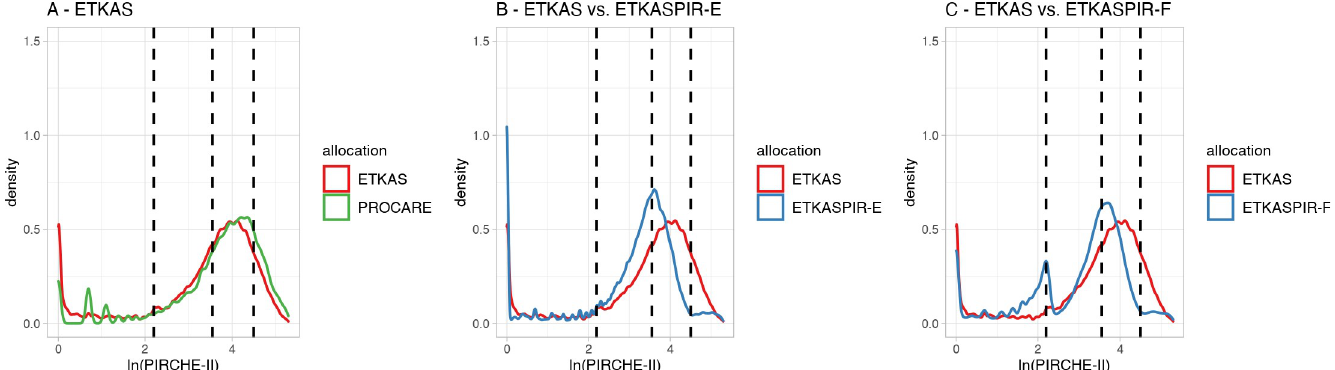
Fig 6. PIRCHE-II score distributions in simulations. The log-transformed PIRCHE-II score distributions resulting from the different ETKAS simulation models. Density plots for the simulations were generated using a Gaussian smoothing kernel. Red lines in graphs A-C represent the PIRCHE-II scores in the ETKAS baseline simulations, the green line in graph A represents the previously reported PIRCHE-II scores as observed in the PROCARE cohort[20], blue lines in graphs B-C represent the PIRCHE-II scores in the PIRCHE-II modified ETKAS simulations for the ETKASPIR-E with priority by HLA match, assignment of points linearly descending, and inclusion of a PIRCHE-II based mismatch probability (MMP) (B), and ETKASPIR-F with priority allocation by PIRCHE-II score, assignment of points linearly descending, and inclusion of a PIRCHE-based MMP (C). Dashed lines indicate the previously reported strata by Lachmann et al.